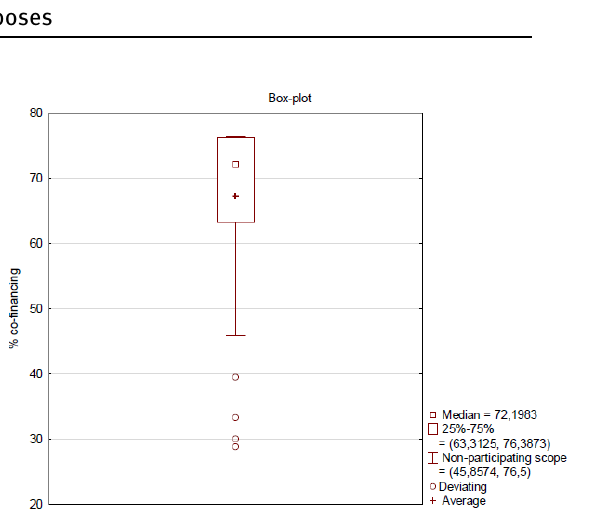
Figure 2: Overview of the percentage of co-financing of the costs of investments covered by the Revitalisation Programme (own elabora- tion)